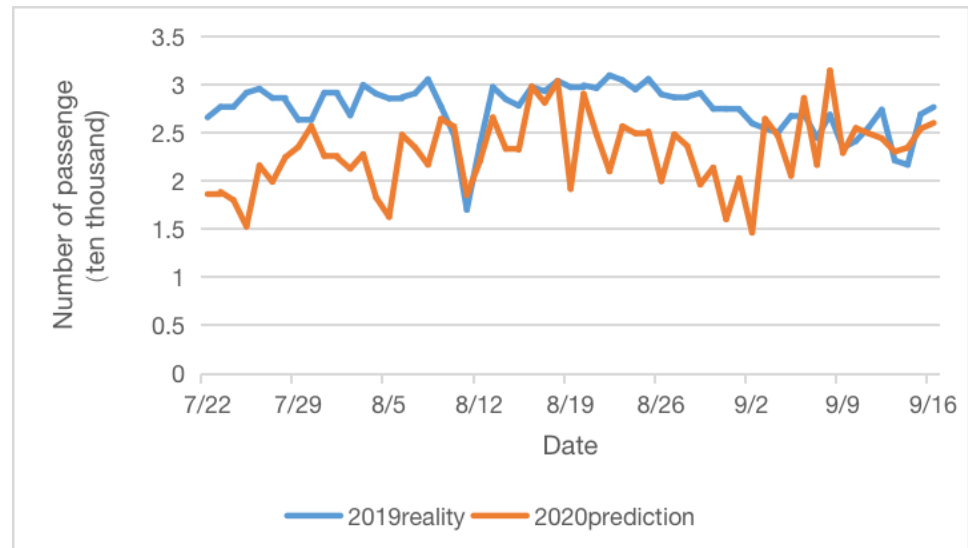
Figure 4. Passenger numbers departing from Dalian (2020 prediction and 2019 reality).